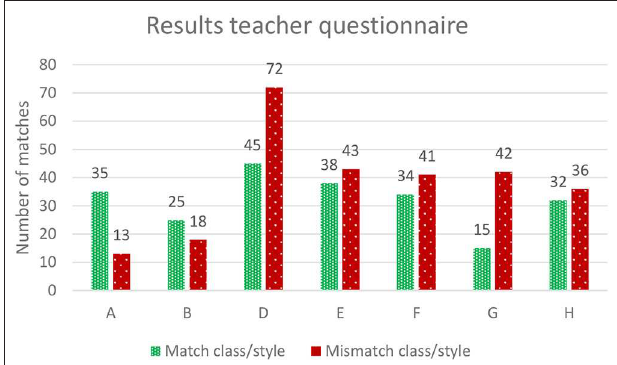
FIGURE 4 | Results of the teacher questionnaire. Shown is the number of statements either correctly or incorrectly matched to the class. Teachers linked classes to guidance style statements. Teacher C did not fill out the questionnaire. Chance level is 29.9% correct, which most teachers transcend (correct matches A: 73%, B: 58%, D: 38%, E: 47%, F: 45%, G: 26%, H: